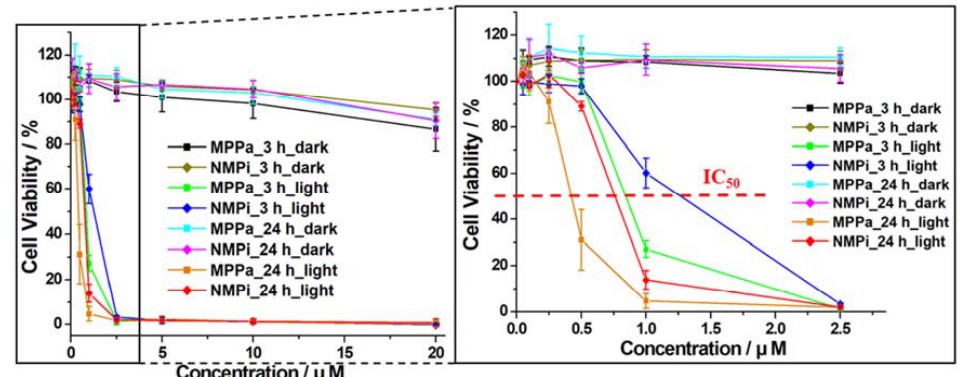
Figure 2. In vitro phototoxicity (total light dose 2 J/cm 2 for 15 min) and dark toxicity against A549 cells by 3 ‐ (4,5 ‐ Dimethylthiazol ‐ 2 ‐ yl) ‐ 2,5 ‐ diphenyltetrazolium bromide) (MTT) assay after 3 and 24 h incubation times at various concentrations (1–20 μ M) of MPPa and NMPi (left), and expanded figure for low concentrations (right). Error bars represent the SD of three replicate experiments. Red dashed line at 50% cell viability presents IC 50 value (half maximal inhibitory concentration).